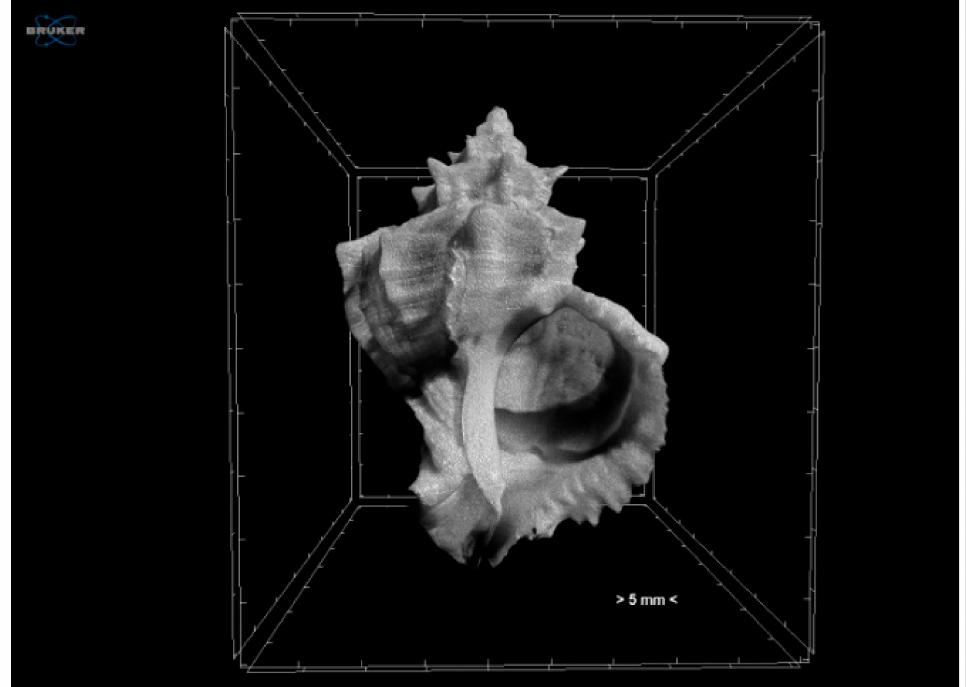
Figure 2. Volume rendering of an adult Hexaplex trunculus shell acquired using a Skyscan 1172 micro-CT scanner.